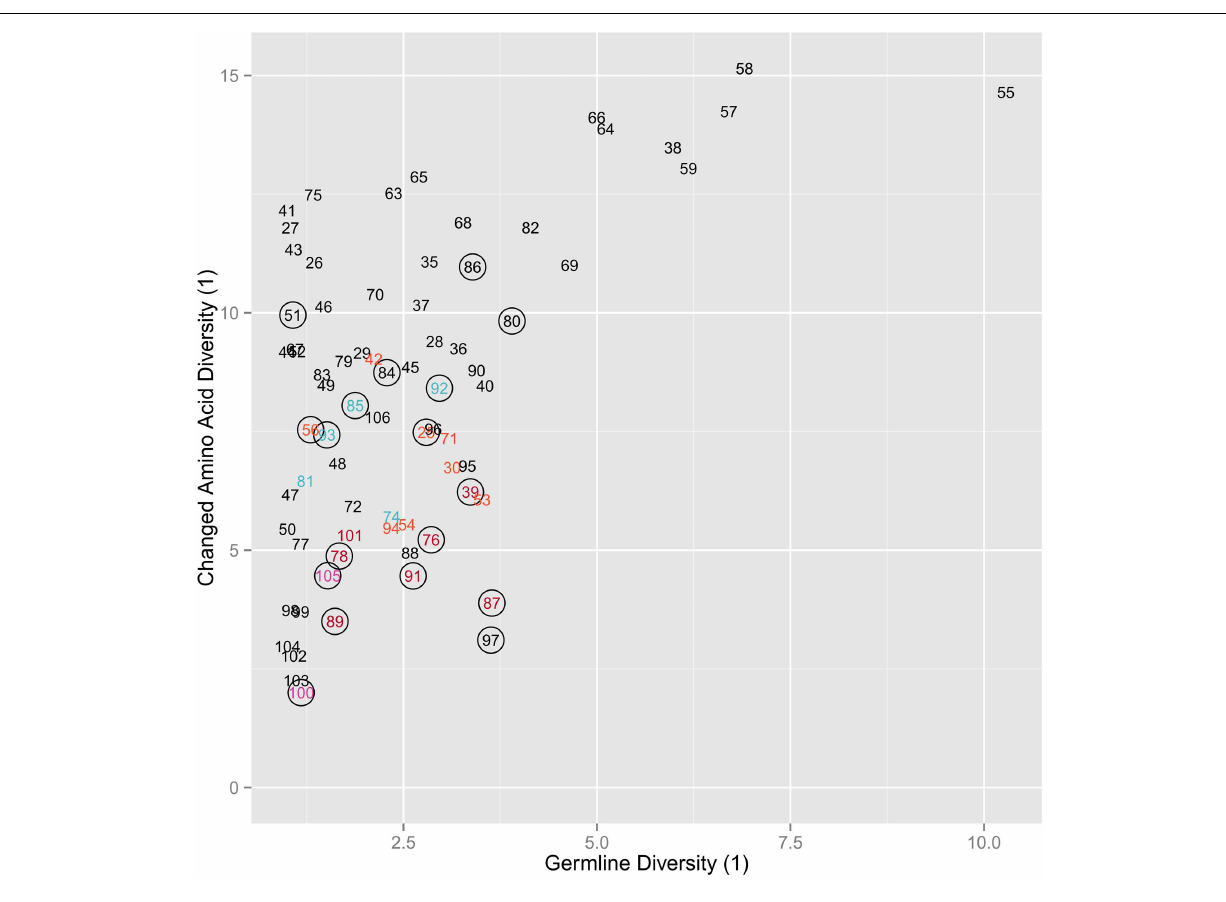
FIGURE 4 | Copy of Figure 3B annotated for amino acid usage bias .The coloring for the labels signifies whether that position is hydrophobic (red), weak hydrophobic (light red), neutral (purple), weak hydrophilic (light blue),